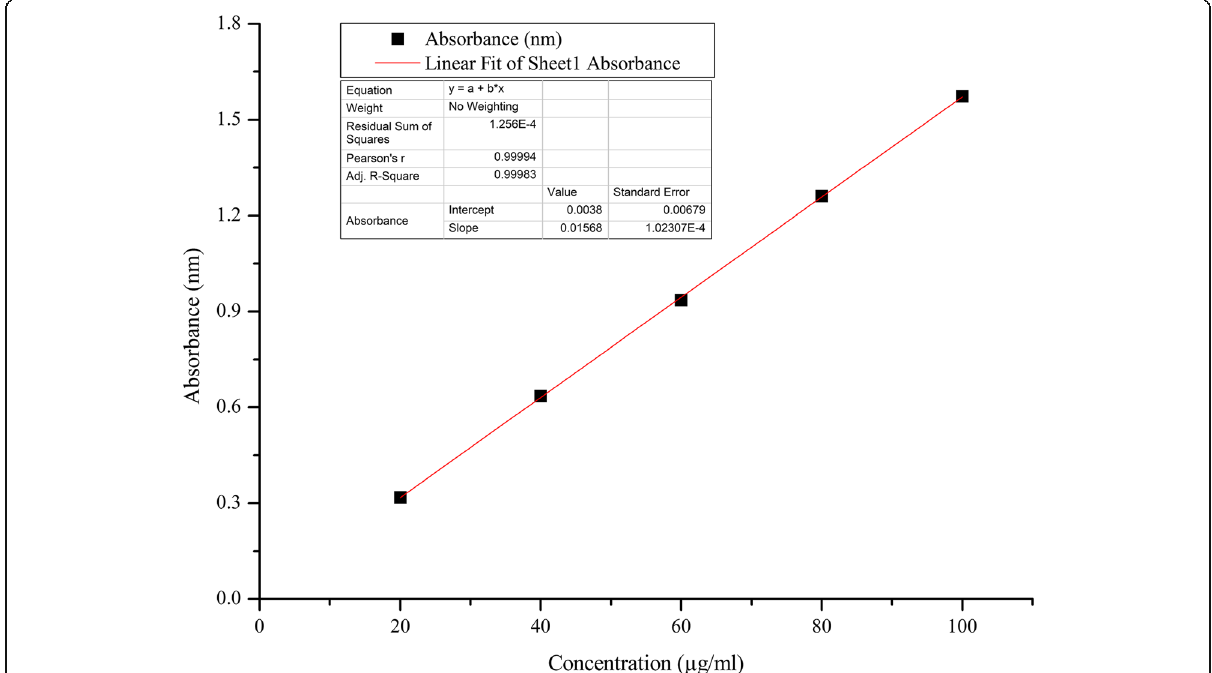
Fig. 1 Calibration curve for determination of total phenolic content using gallic acid in methanolic and ethanolic extracts of C. zeylanica leaves